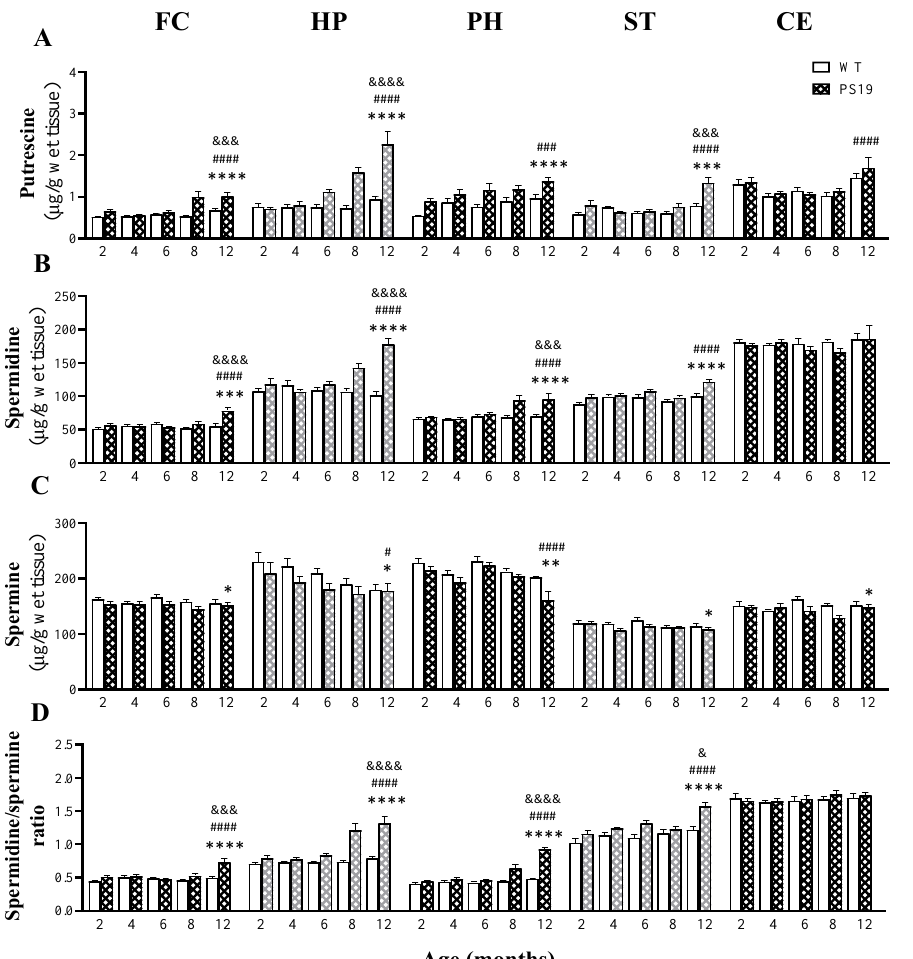
Figure 4. Mean ( ± SEM) levels of putrescine ( A ), spermidine ( B ), spermine ( C ) and the spermi- dine/spermine ratio ( D ) in the frontal cortex (FC), hippocampus (HP), parahippocampal region (PH), striatum (ST) and cerebellum (CE) of wildtype (WT) and PS19 mice at 2, 4, 6, 8 and 12 months of age ( n = 7–9/genotype/age). & indicates a significant genotype and age interaction at & p < 0.05, &&& p < 0.001 or &&&& p < 0.0001. # indicates a significant age effect at # p < 0.05, ### p < 0.001 or #### p < 0.0001. * indicates a significant genotype effect at * p < 0.05, ** p < 0.01, *** p < 0.001 or **** p < 0.0001.